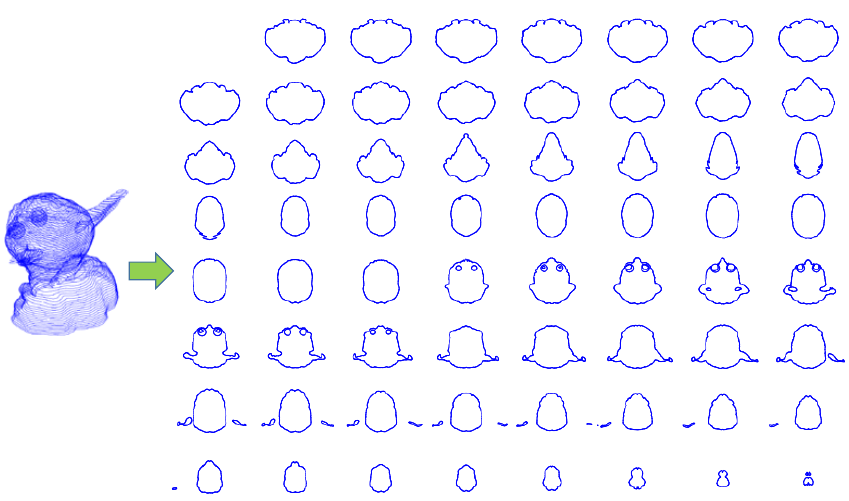
Figure 4. The 2D slices of a 3D printing model in 2D space.